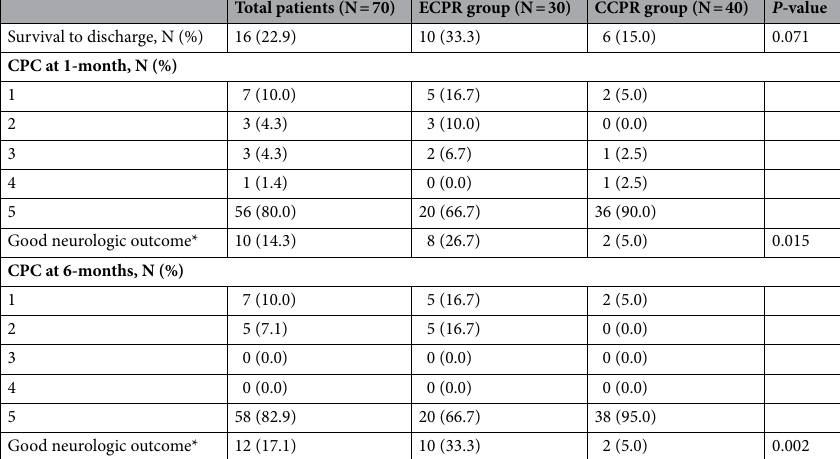
Table 2. Neurologic outcomes. ECPR extracorporeal cardiopulmonary resuscitation, CCPR conventional cardiopulmonary resuscitation, CPC cerebral performance category. *CPC 1 or